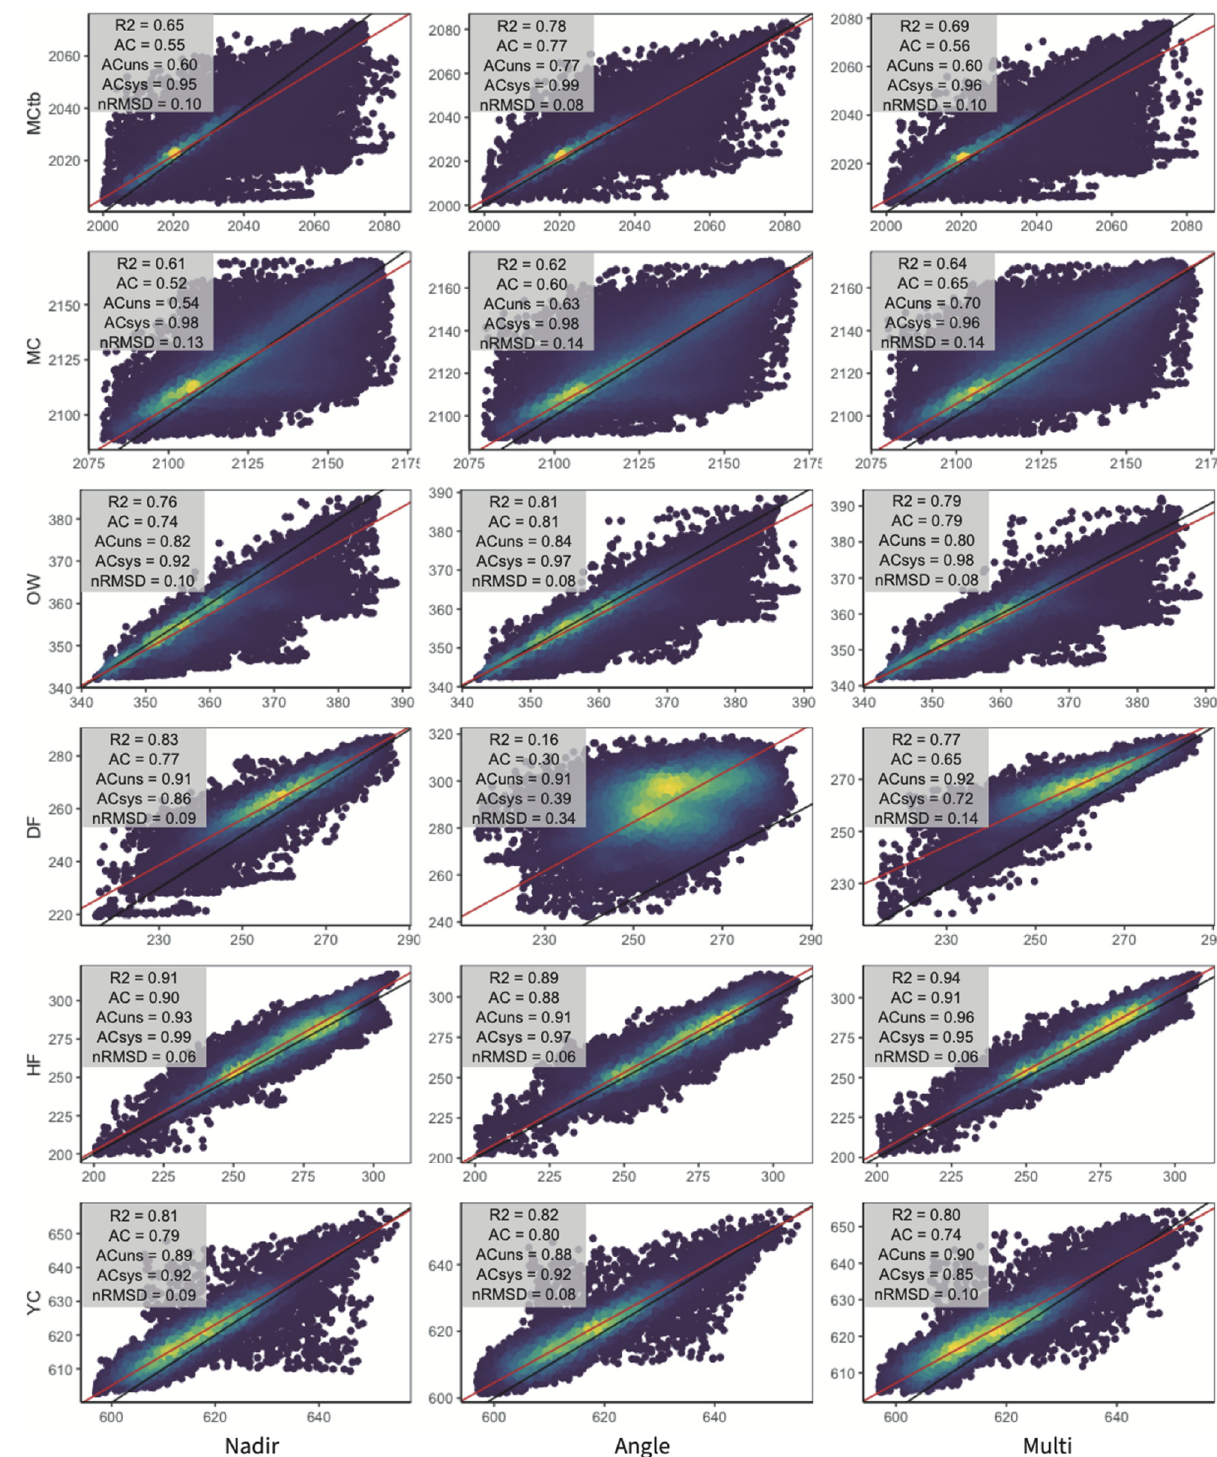
Figure 4. Comparison of site-specific digital surface models (DSM) generated from UAS DAP (nadir, angled, and multi- angled) versus lidar. The X axis is DAP and the Y axis is lidar. Geometric mean fit regression line in red, 1:1 line in black, points are colorized by density of observations (i.e., number of raster pixels) with lighter regions (yellow) indicating greater density of observations and darker regions (blue) being less dense. R-squared, root mean square deviation (RMSD), normalized RMSD (nRMSD), agreement coefficient (AC), systematic agreement coefficient (AC sys ) and unsystematic agreement coefficient (AC uns ) are shown for each model comparison.